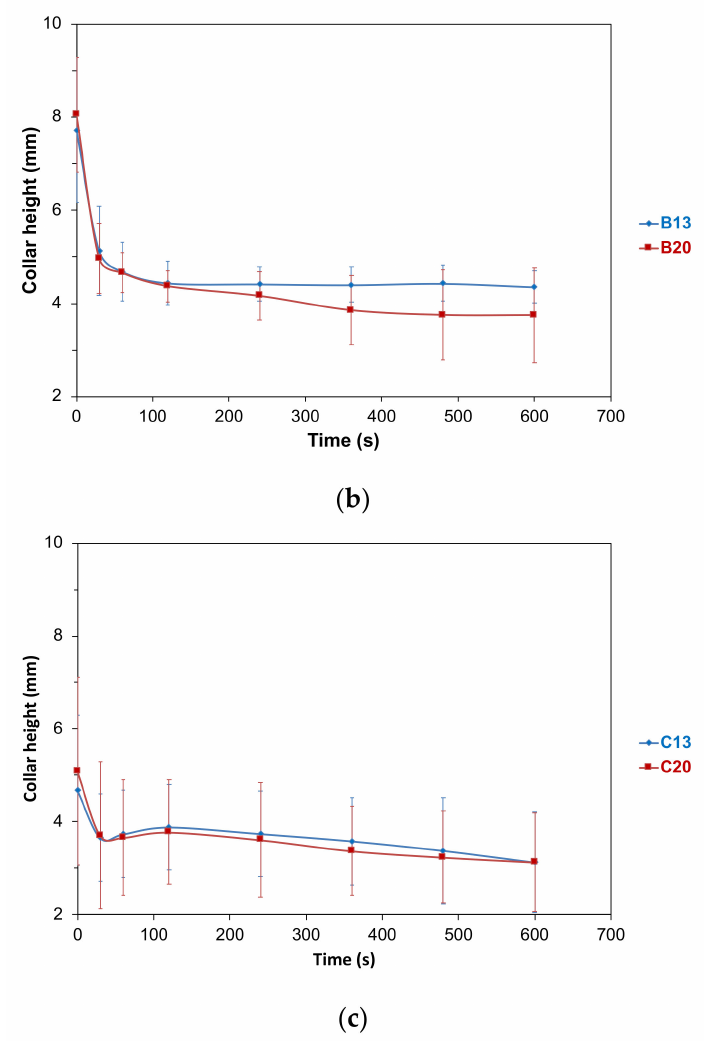
Figure 4. Evolution of the foam collar under standardized tasting conditions, during ten minutes after the end of pouring of ( a ) wine samples A, ( b ) wine samples B, and ( c ) wine samples C. Heights of foam that are significantly different, are denoted with an asterisk (with P <